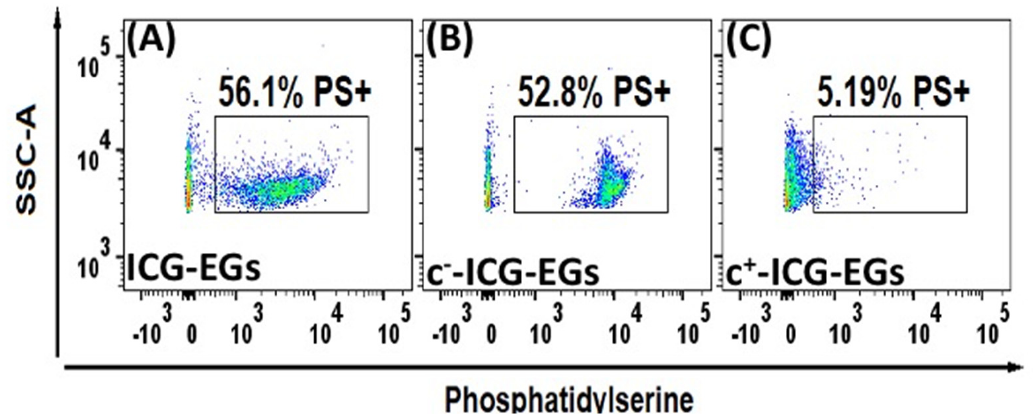
Figure 8. Quantification of PS on the outer leaflet of ( A ) ICG-EGs (negative control), ( B ) cholesterol-depleted ICG-EGs (c - -ICG-EGs) (positive control), and ( C ) cholesterol-enriched ICG-EGs (c + -ICG-EGs). Particles were fabricated using human RBCs, and loaded with ICG in hypotonic buffer. We show representative dot plots of side scattering vs. fluorescence emission of AlexaFluor 488-labeled annexin V, which targets surface-exposed PS. Boxed regions correspond to PS-positive particles. The indicated percentages refer to the fraction of the particles in the sample population that are PS-positive, and represent the average of four measurements on each sample.